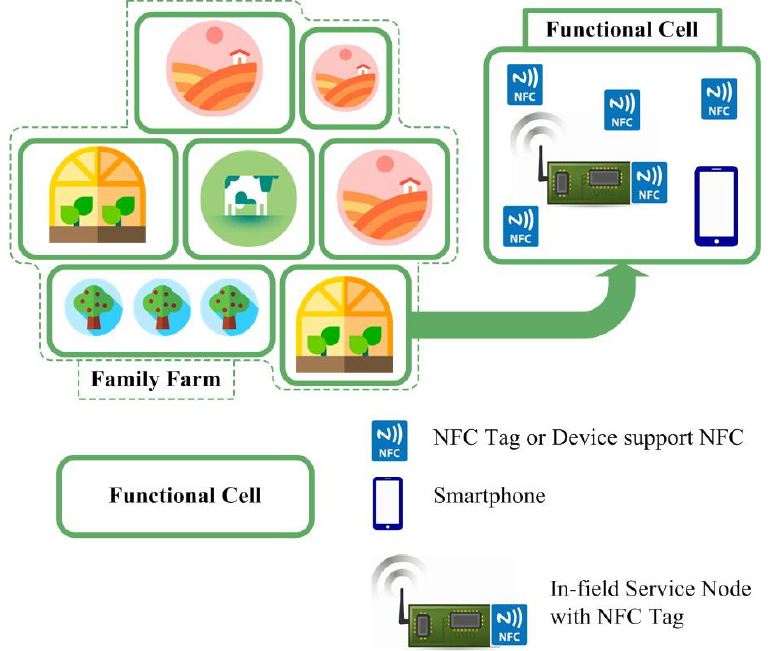
Figure 2. Schematic of the function cells in family farm.